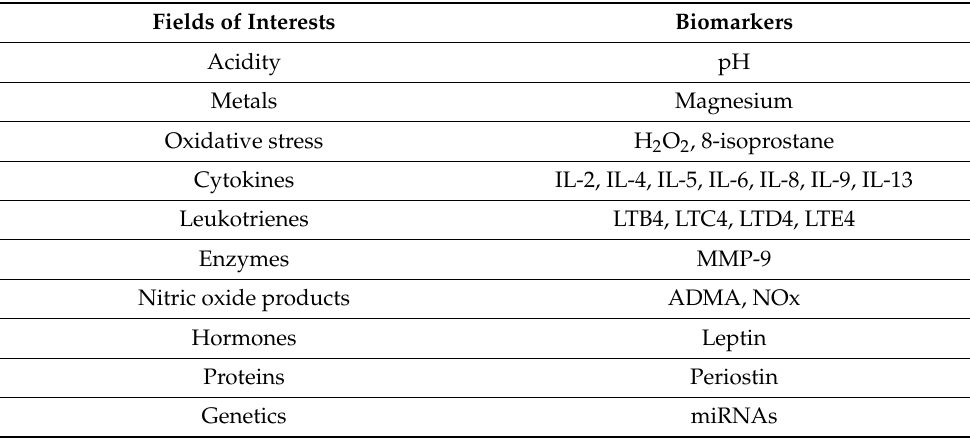
Table 2. Biomarkers detected in